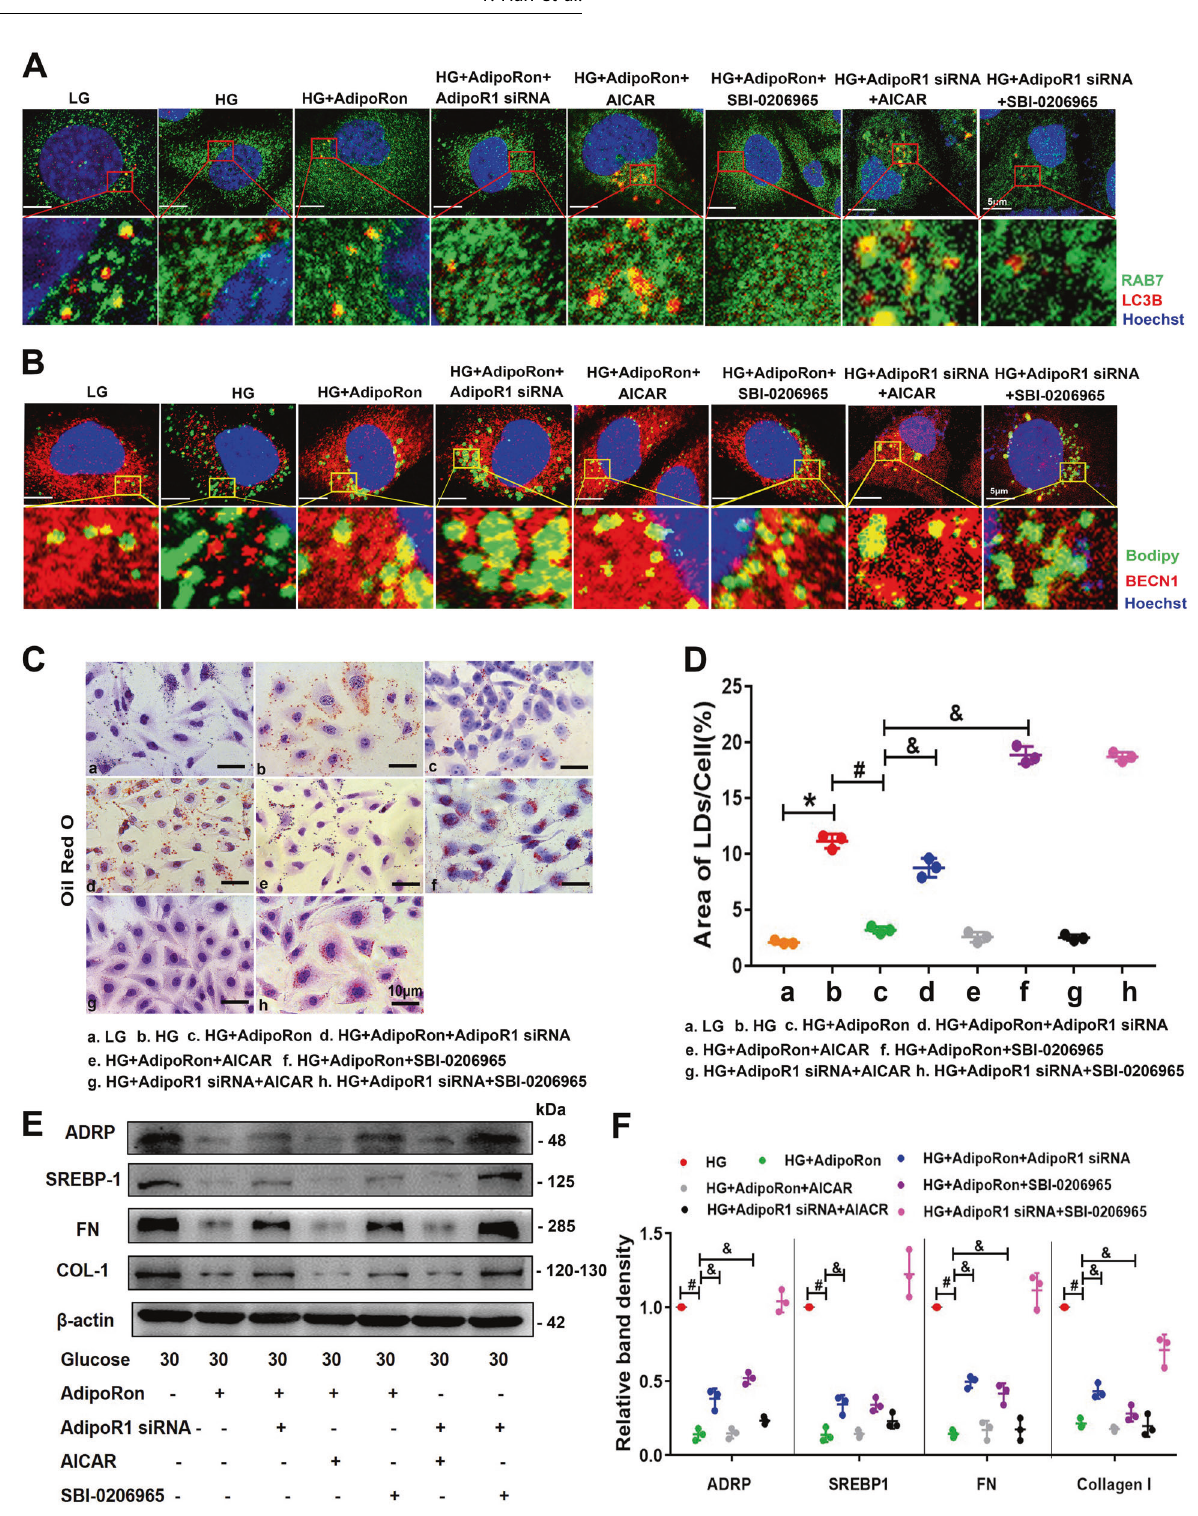
Fig. 7 The effects of AdipoRon on increasing lipohagy and alleviating lipid deposition and fi brosis were partially blocked by ULK1 inhibitor, while enhance by AMPK activator. Confocal IF images showing the co-localization of RAB7 and LC3B and the co-localization of BECN1 and LDs (Bodipy) in HK-2 cells exposed to HG conditions and pretreated with or without AdipoRon, AdipoR1 siRNA, AICAR and SBI- 0206965 ( A , B ). Representative images and semiquanti fi cation of the lipid deposition in HK-2 cells exposed to an HG environment pretreated with AdipoRon, AdipoR1 siRNA, AICAR and SBI-0206965 ( C , D ). WB and densitometric analysis of ADRP, SREBP-1, FN and Collagen I expressions in HK-2 cells exposed to HG conditions with or without AdipoRon, AdipoR1 siRNA, AICAR and SBI-0206965 ( E , F ). Values are the mean ± SD; * p < 0.05 versus LG group, # p < 0.05 versus HG group. n = 3.